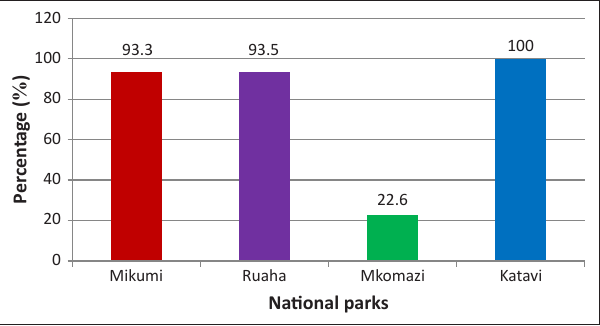
FIGURE 2: FMDV infection status in buffalos from four selected Tanzanian national